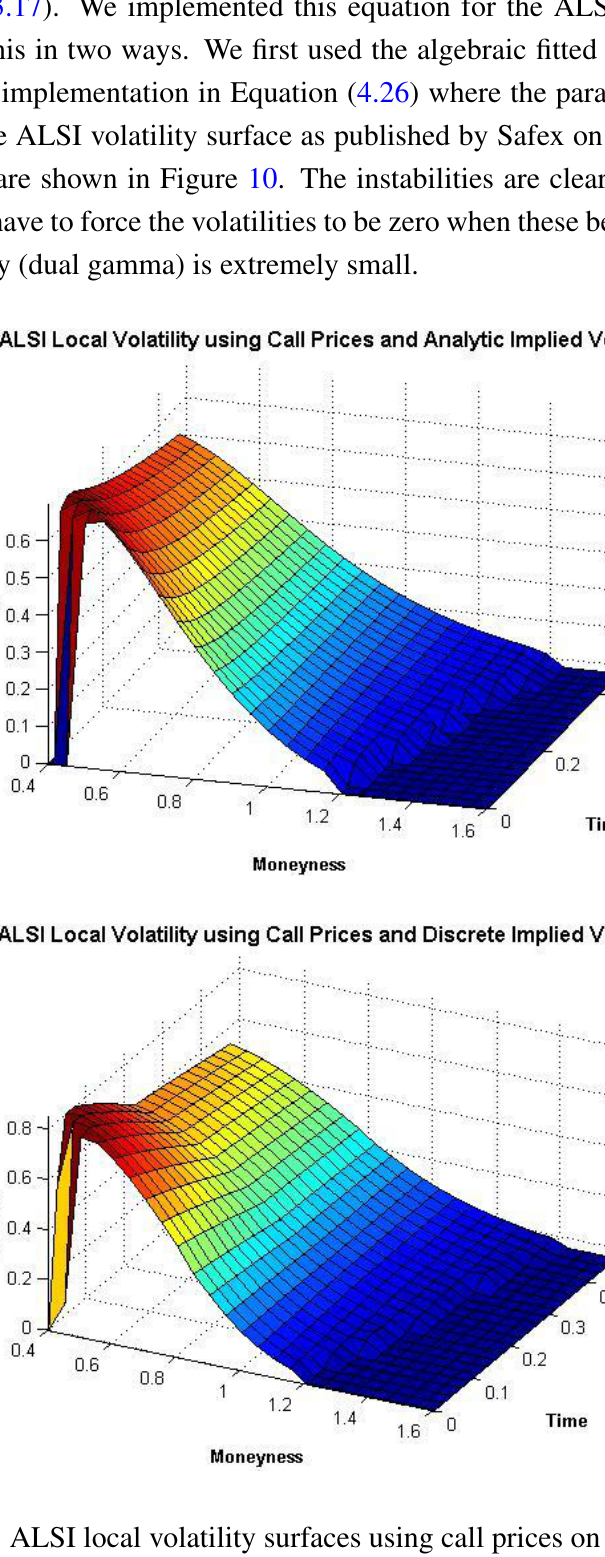
Figure 10. ALSI local volatility surfaces using call prices on 28 May